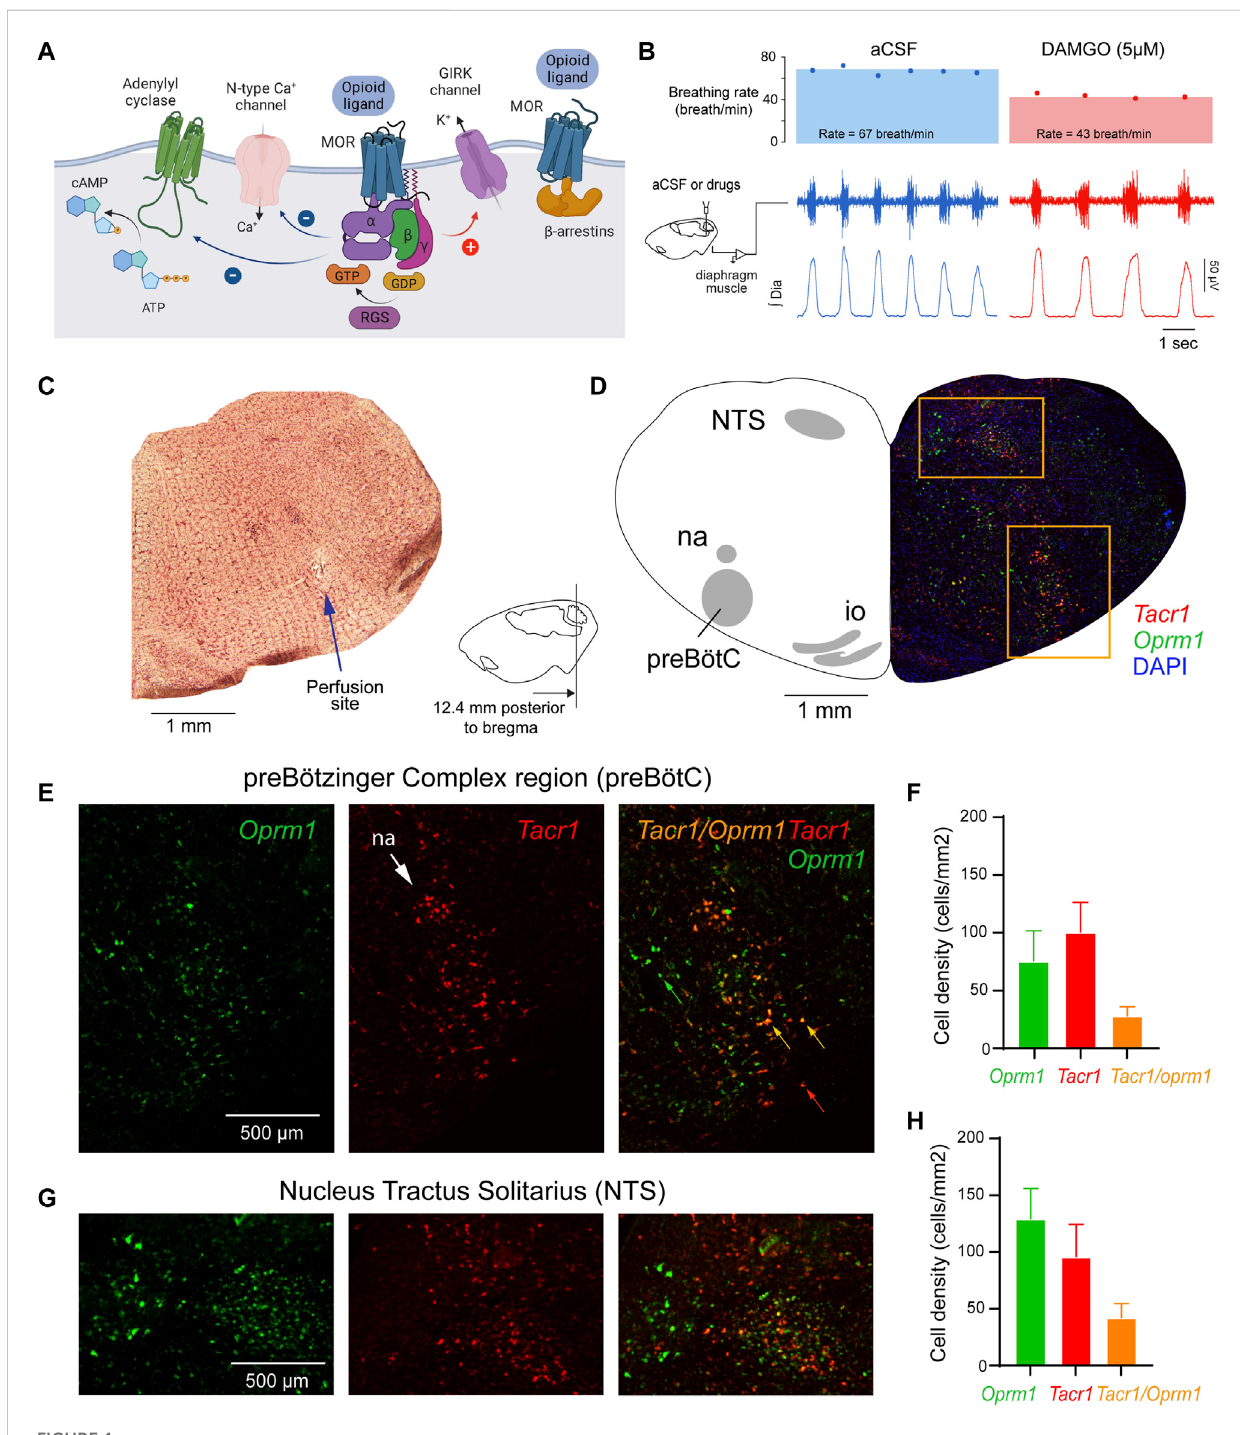
FIGURE 1 Neuralmechanismsof neuronal inhibition by MORs and expression of Oprm1 and Tacr1 (the gene encoding neurokinin-1receptors) inthemedulla. (A) NeuronalinhibitionbyMORsisregulatedbyG-protein-signalingincluding α , ß and γ proteinsandregulatorsofG-proteinsignaling. (B) Microperfusion of the MOR agonist DAMGO directly into the preBötC depressed respiratory rate in anesthetized rats. (C) The location of the microperfusion site was identi fi edwithhistological lesionmadebythemicrodialysisprobe shaft. Notethat theprobeextends beyondtheguide by0.5 mm. (D) The preBötC and the nucleus tractus solitarius (NTS) expressed Oprm1 (the gene coding for MORs) and Tacr1 (the gene coding for tachykinin-1 or neurokinin-1 receptors) mRNAs (E, F) The density of Oprm1 and Tacr1 were assessed in the preBötC and the NTS (G, H). MOR, µ-opioid receptor. GTP, guanine trisphosphate. GDP, guanine diphosphate. RGS, regulators of G-protein-signaling. GIRK, G-protein-activated inwardly rectifying potassium channels. Dia, diaphragm muscle. aCSF, arti fi cial cerebrospinal fl uid. Mean data are presented as means ± SEM. Panel a was created using